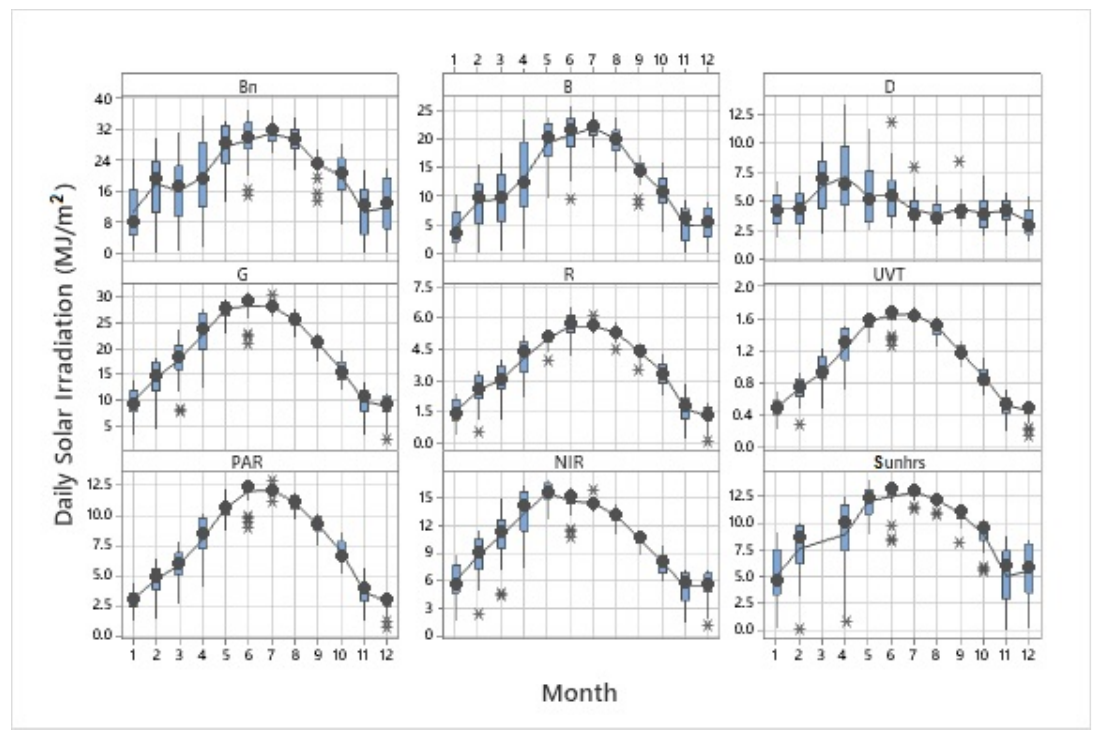
Figure 24. Boxplots of daily solar irradiation (MJ/m 2 ) of all radiation components. The smooth line represents the mean daily values of each month for each variable.